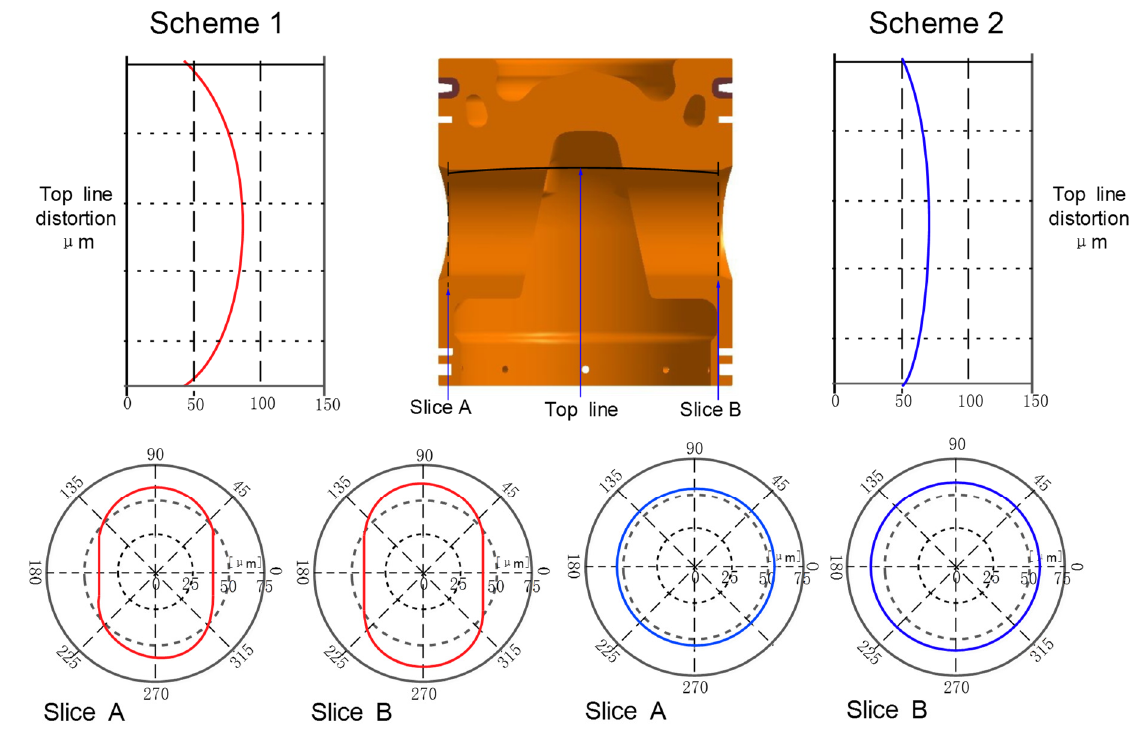
Figure 8. Pin bore deformation under the two schemes.